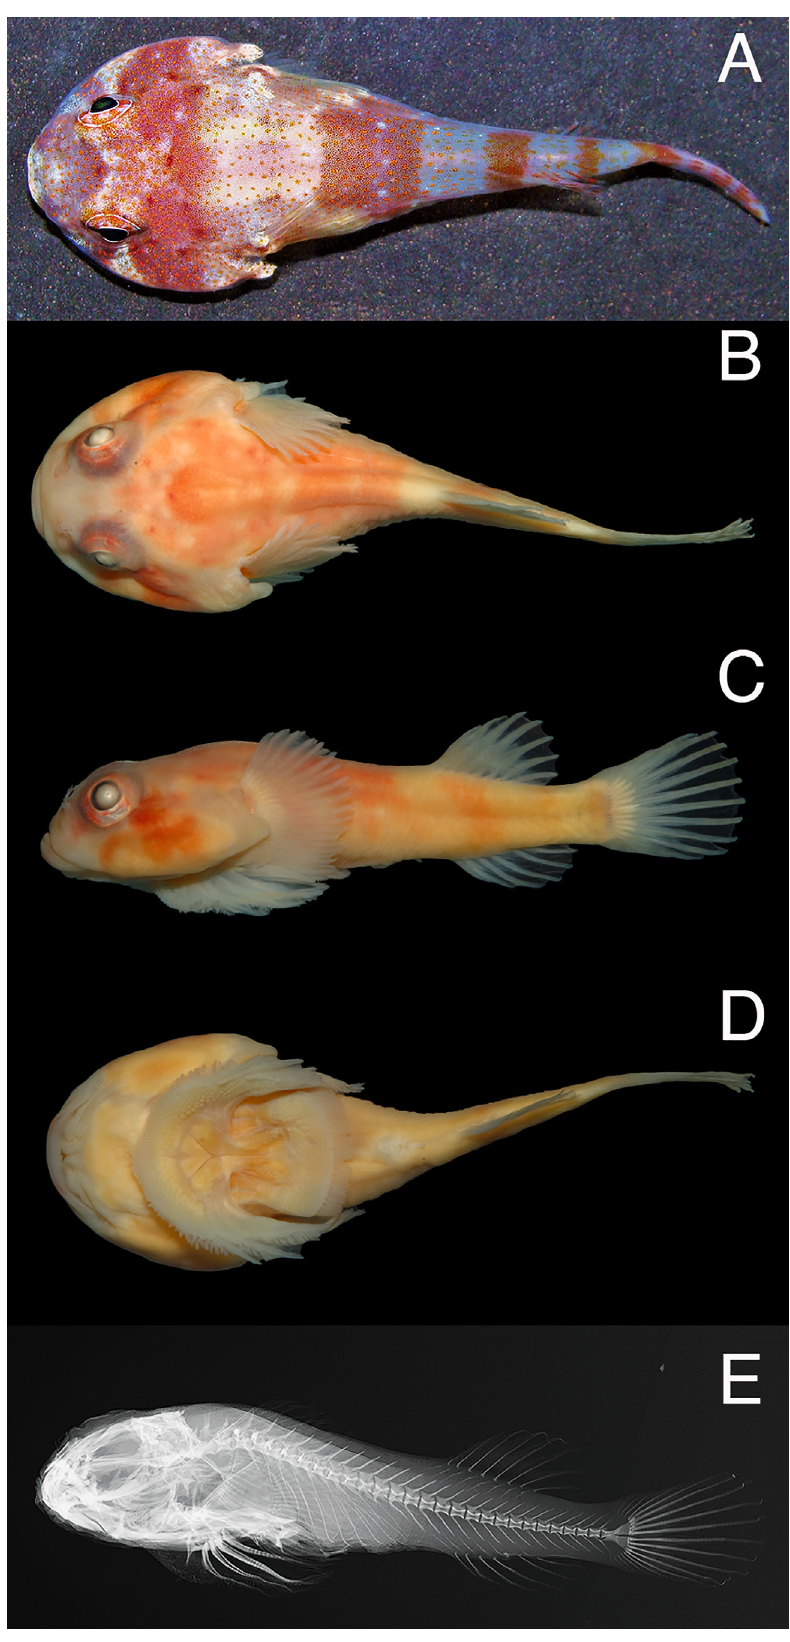
FIGURE 1 | Acyrtus simon , holotype CIUFES 2915, 26.41 mm SL. A. Specimen alive, photo taken by J. L. Gasparini in June 2009; B – D. Specimen preserved, photo taken by R. M. Macieira on 31 October 2020. E. X-ray taken by M. M. Mincarone on 11 May